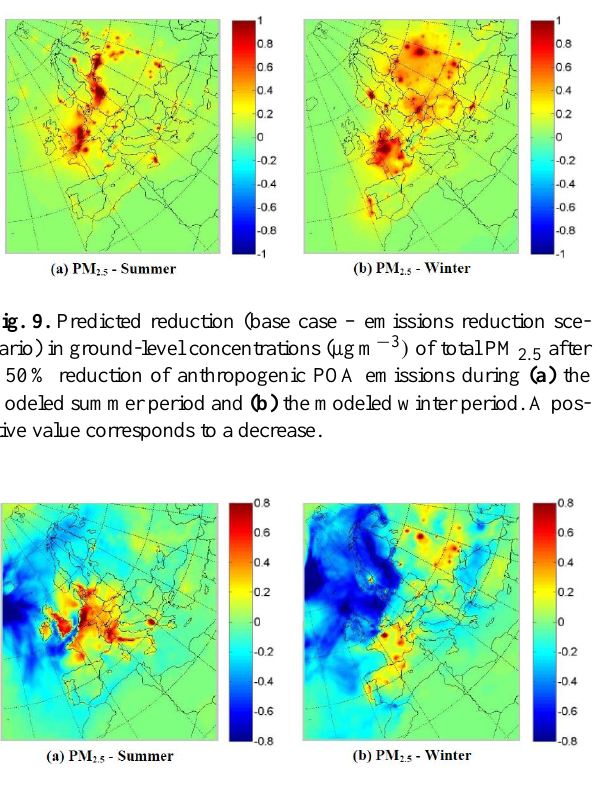
Fig. 10. Predicted reduction (base case – increased temperature sce- nario) in ground-level concentrations (µgm − 3 ) of total PM 2 . 5 after Figure 10. Predicted reduction (base case - increased temperature scenario) in ground-level 3 a 2.5 K increase of temperature during (a) the modeled summer concentrations (μg m -3 ) of total PM 2.5 after a 2.5 K increase of temperature during (a) the 4 period and (b) the modeled winter period. A positive value corre- modeled summer period and (b) the modeled winter period. A positive value corresponds to a 5 sponds to a decrease. decrease. 6